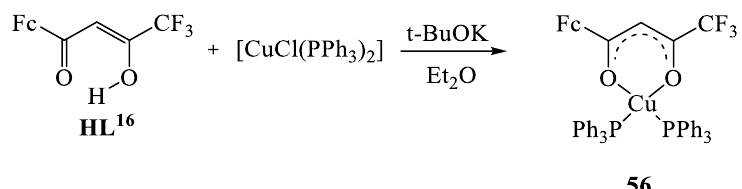
Scheme 23. Synthesis of heterometallic [Cu-Fe] complex 56.